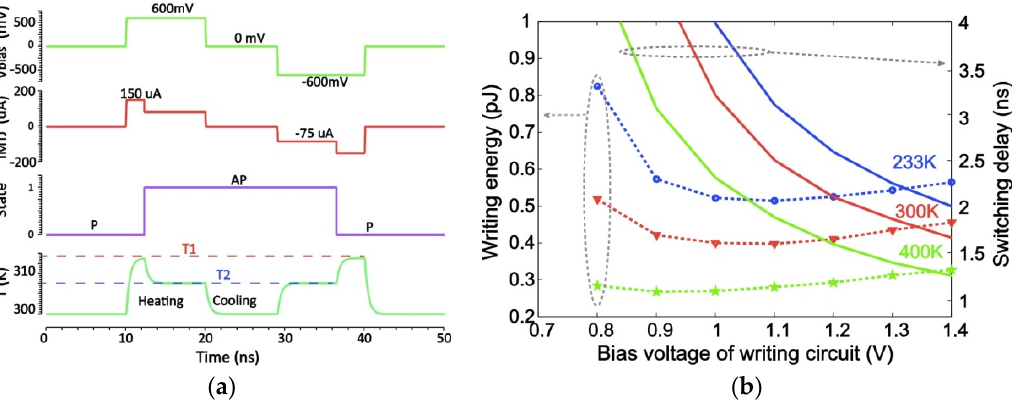
Figure 8. ( a ) Switching delay and energy consumed (dashed line) during writing process versus the bias voltage of STT ‐ MRAM writing. ( b ) Cumulative breakdown probability distribution of 28 ‐ nm FD ‐ SOI MOS devices and STT ‐ MTJ [34].